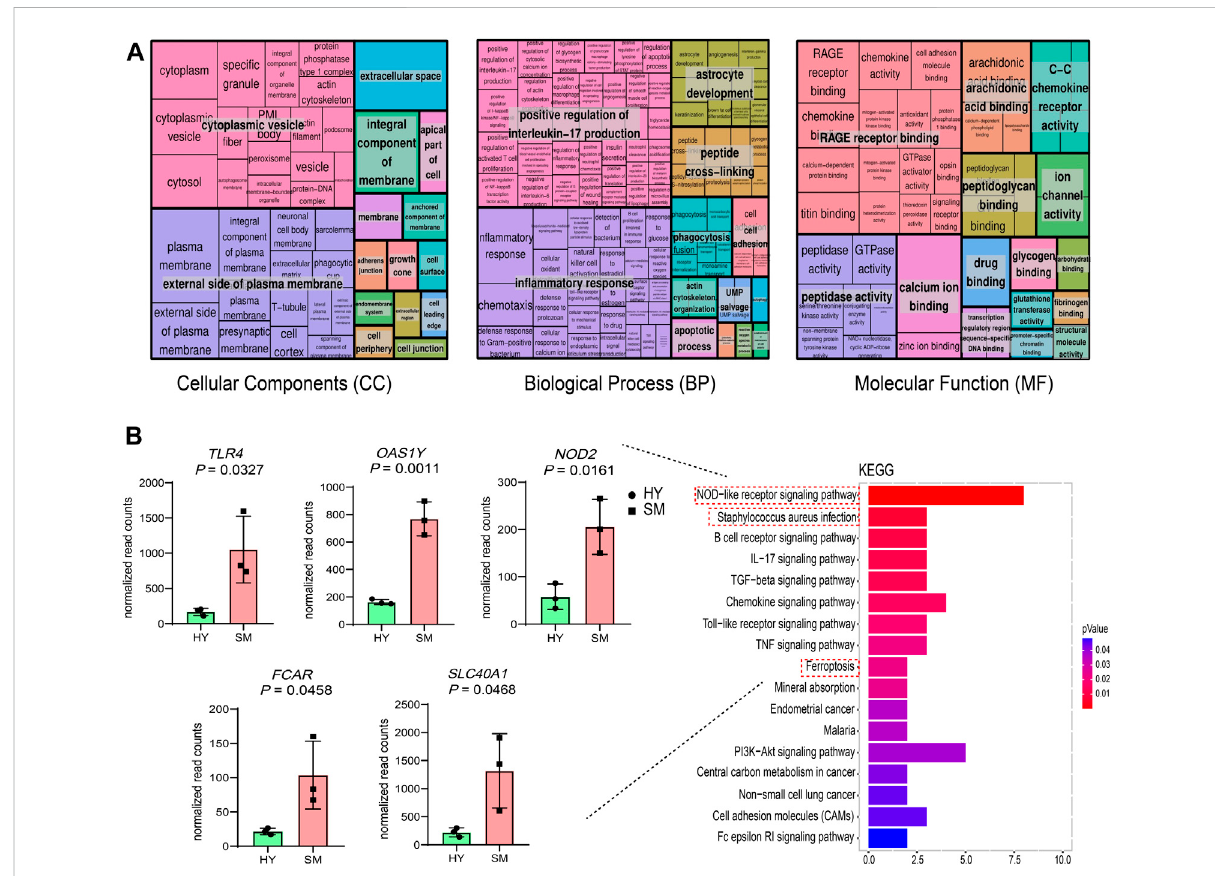
FIGURE 3 ResultsofGOandKEGGanalysisof287differentiallyexpressedgenes(DEGs)insubclinicalmastitis(SM)cows vs. healthy(HY)cows. (A) REVIGO summary and visualization of the signi fi cant Go terms ( p -value < 0.05), including 190 GO terms of biological process (BP), 50 GO terms of cellular components (CC), and 56 GO terms of molecular function (MF). (B) KEGG pathways of DEGs ( p -value < 0.05), and expression differences of